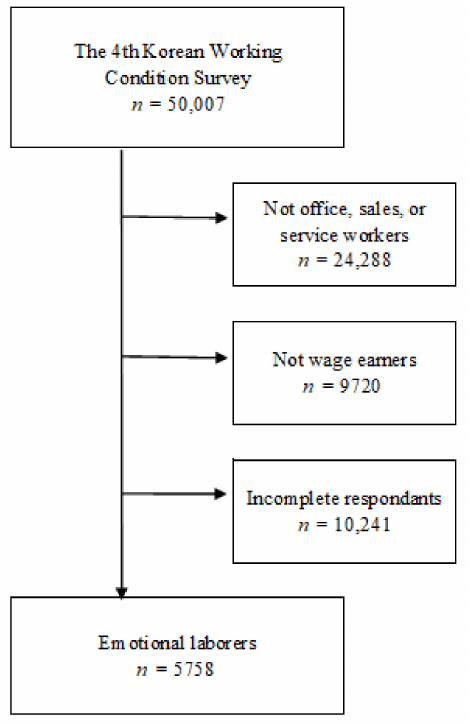
Figure 1. Flow chart of the study population selected for the